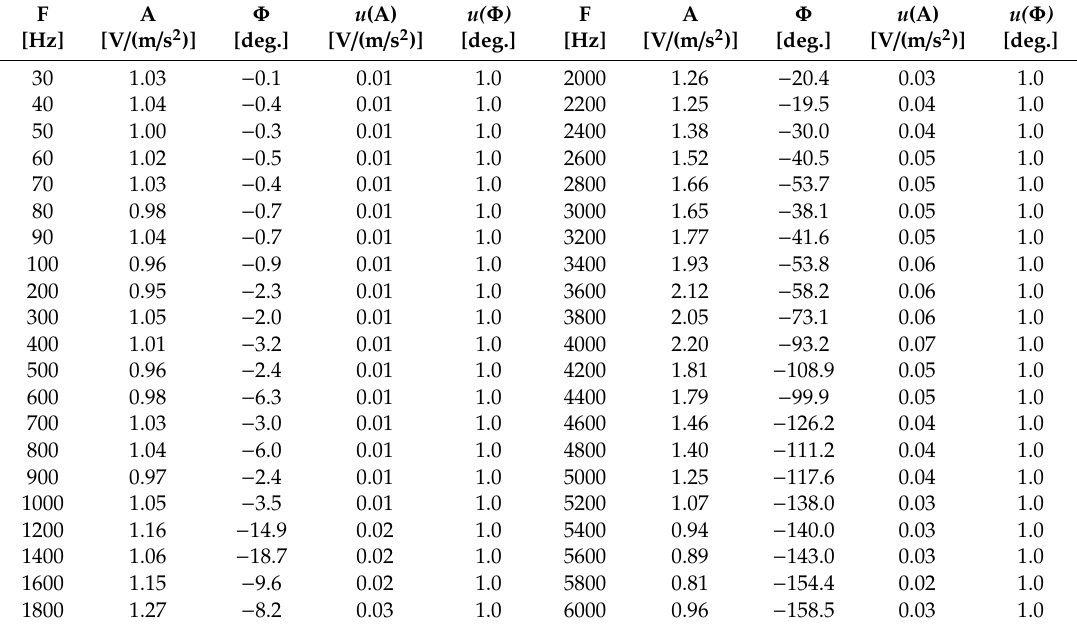
Table 1. Measurement points of the frequency responses together with expanded uncertainties ( k = 2) for the accelerometer DJB A / 1800 /